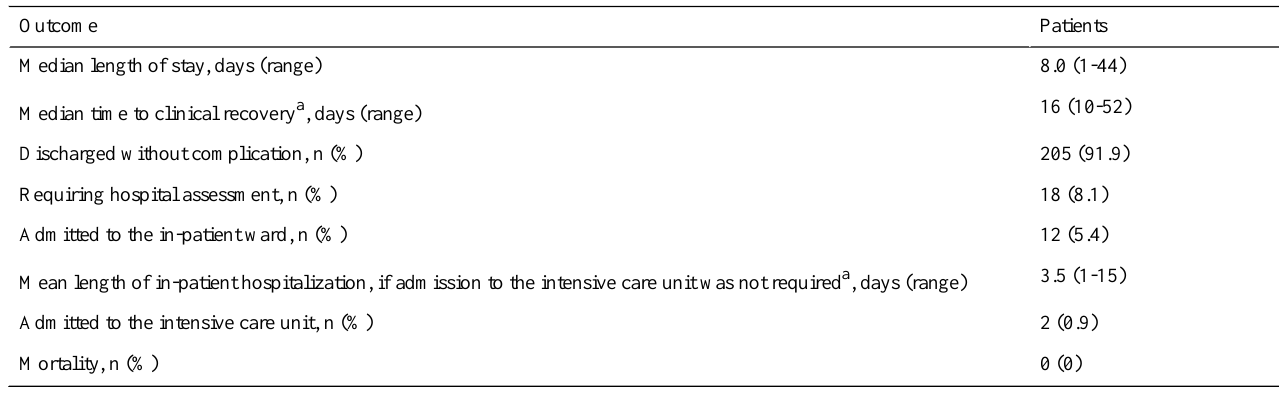
Table 2. Virtual ward patient outcomes